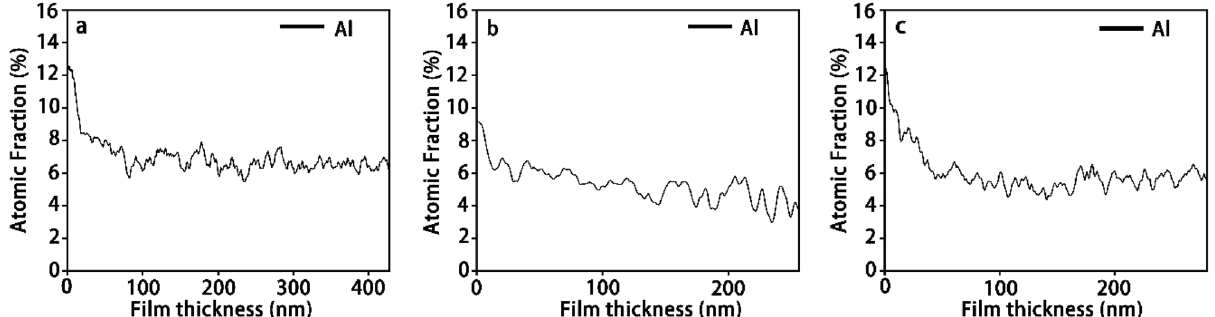
Figure 5. Aluminum atomic fractions along the film thickness from the Si-HEA interface to the thin film surface for ( a ) the thin film with 0 V substrate bias; ( b ) the thin film with −50 V substrate bias; and ( c ) the thin film with −100 V substrate bias. The left side represents the substrate, and the right side represents the thin film surface in each figure.